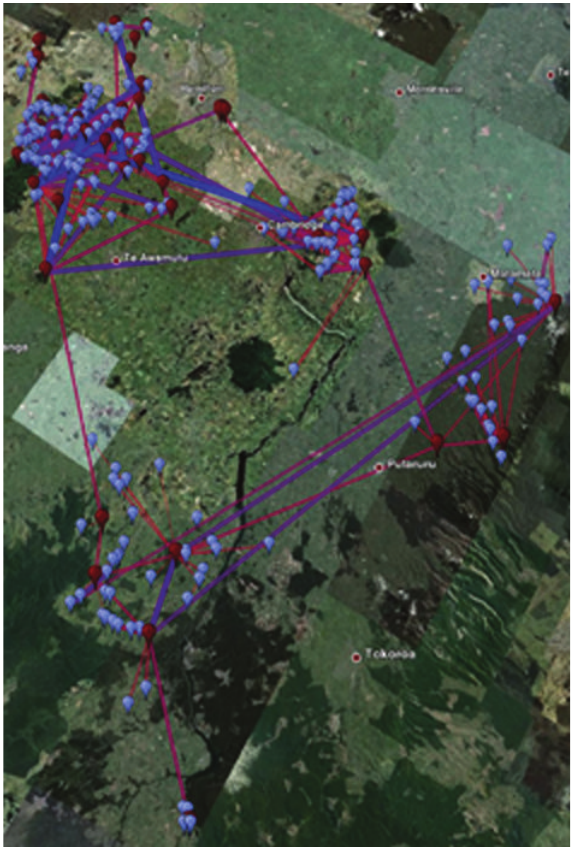
Figure 1: The largest of three disconnected sections of the network (80 × 100 km). Link color indicates strength: blue implies strong, red implies weak. Backhaul nodes (mainly 5.8 GHz) are red and CPEs are light